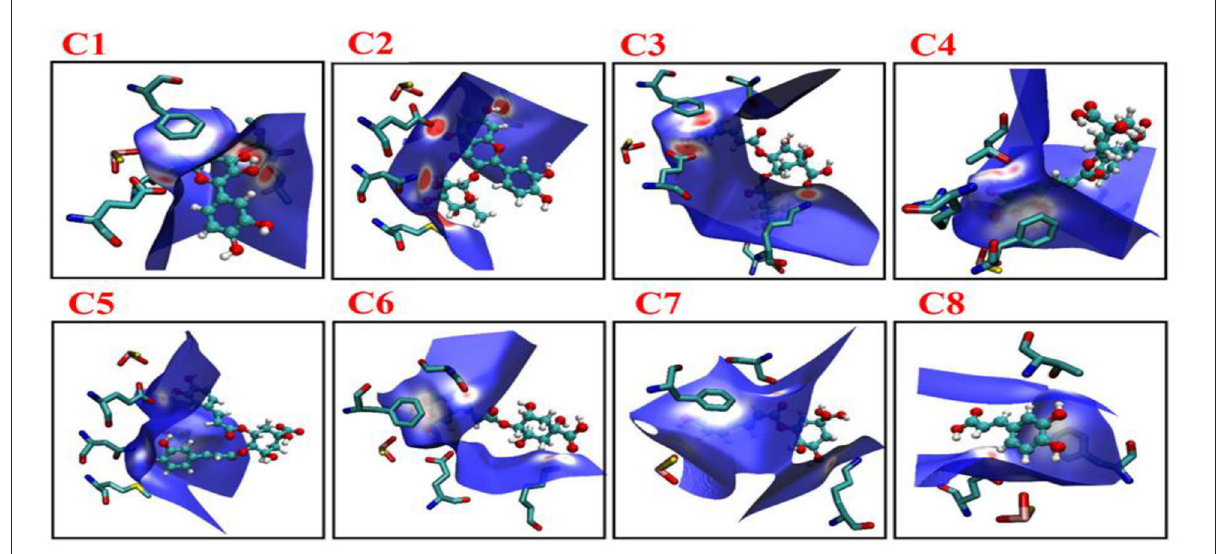
FIGURE8 Images showing the Hirshfeld surfaces that use color-coding to represent the proximity of close contacts around residues in phenolic compounds C1–C8 in different system (white, distance d equals the van der Waals distance; blue, d exceeds the van der Waals distance; red, d is less than van der Waals distance). C1, quercetin; C2, quercetin-3-rhamnoside; C3, 4,5-O-dicaffeoylquinic acid; C4, 3,5-O-dicaffeoylquinic acid; C5, 3,4-O-di-caffeoylquinic acid; C6, 4-O-caffeoylquinic acid; C7, 3-O-caffeoylquinic acid; and C8, caffeic acid.